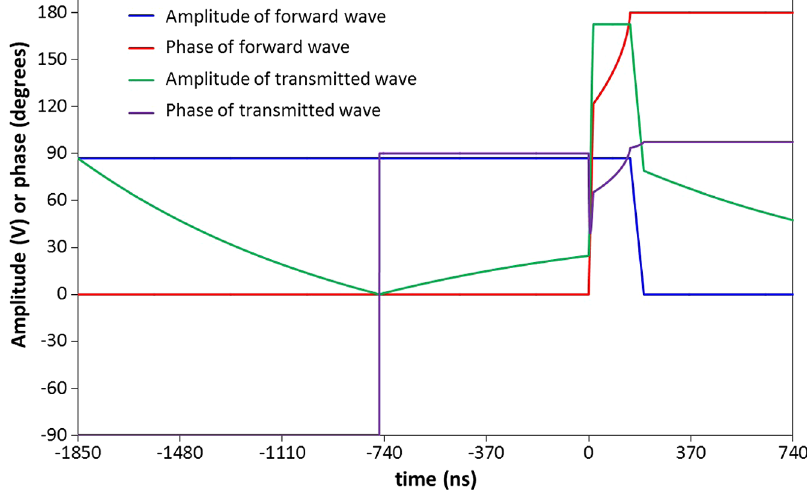
FIG. 8. Simulated performance for amplitude control using a phase ramp.